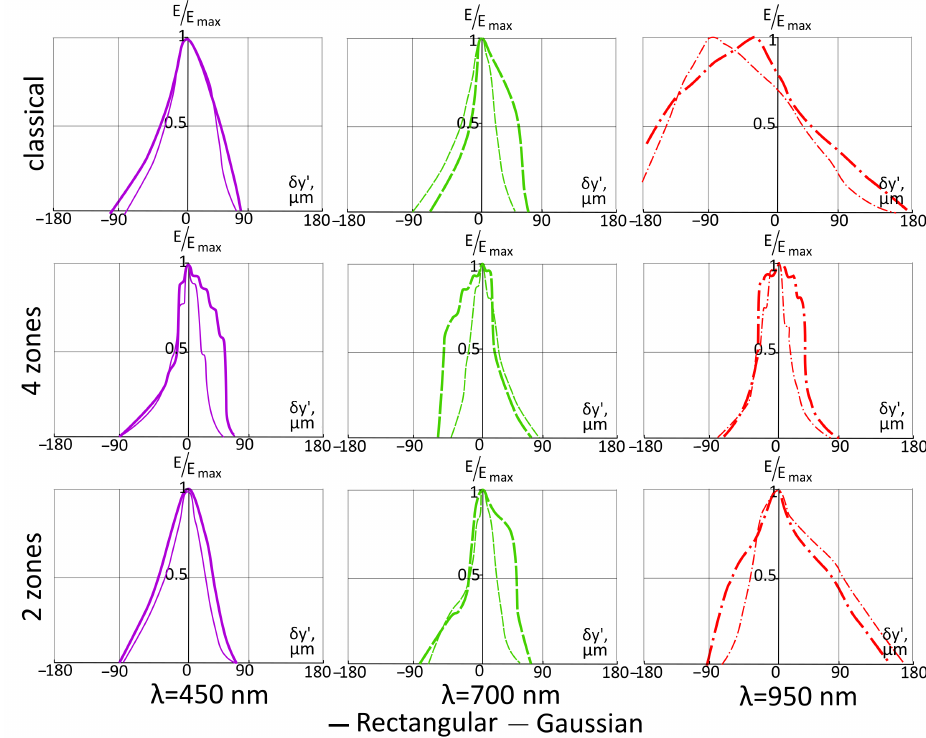
Figure 7. Instrument functions of the slitless spectrograph for a 3.5 (cid:48)(cid:48) object in the FoV